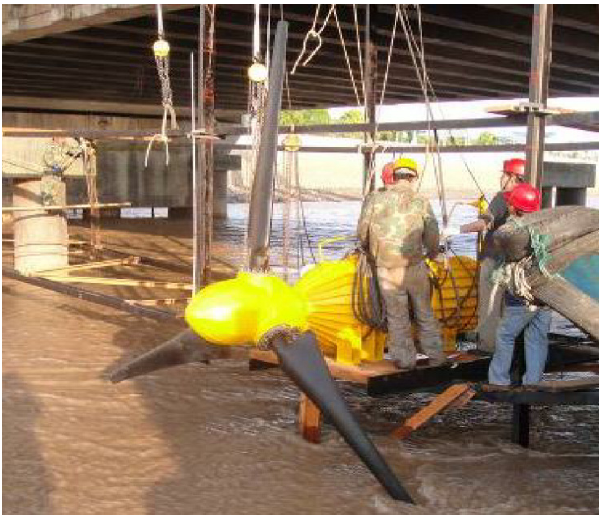
Figure 18. The 25 kW horizontal-axis semi-direct-drive TCPGS. Reproduced from [21], Elsevier. In 2013, ZJU started to develop a “60 kW semi-direct-drive horizontal-axis TCPGS with large length-diameter ratio” independently of SFPMRE (see in Figure 19). PMSG